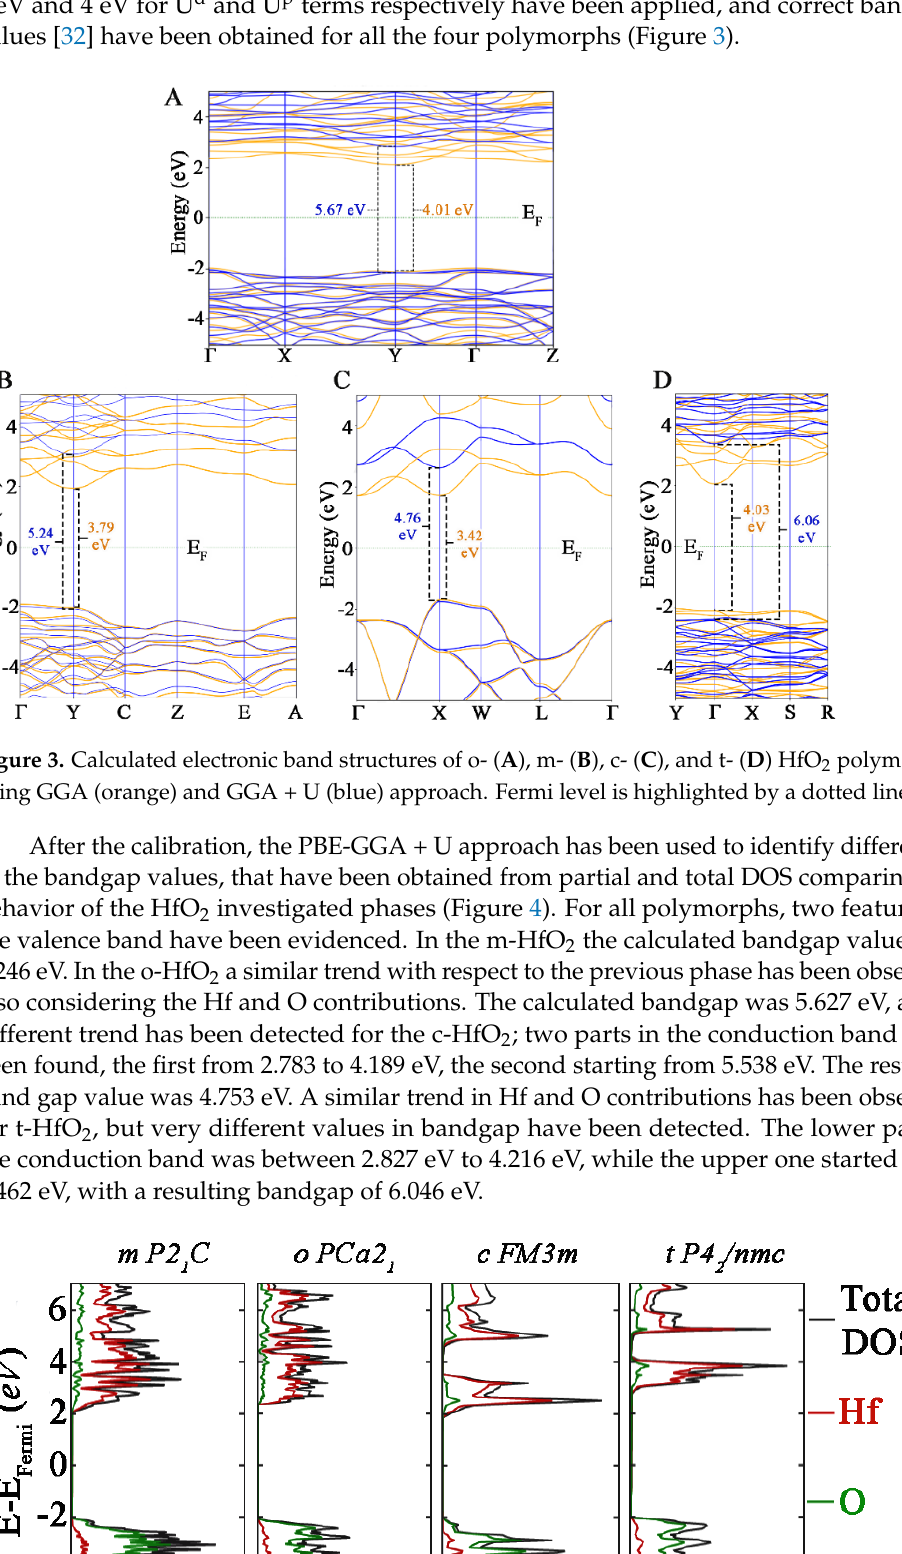
Figure 4. partial and total DOS of HfO 2 polymorphs investigated. The m- P2 1 c , o- PCa2 1 , c- FM3m , and t- P4 2 /nmc are reported to note the differences between the polymorphs. To outline the differences in the phase behavior in response to an applied field, die- lectric properties as a function of frequencies have been calculated including inter-band